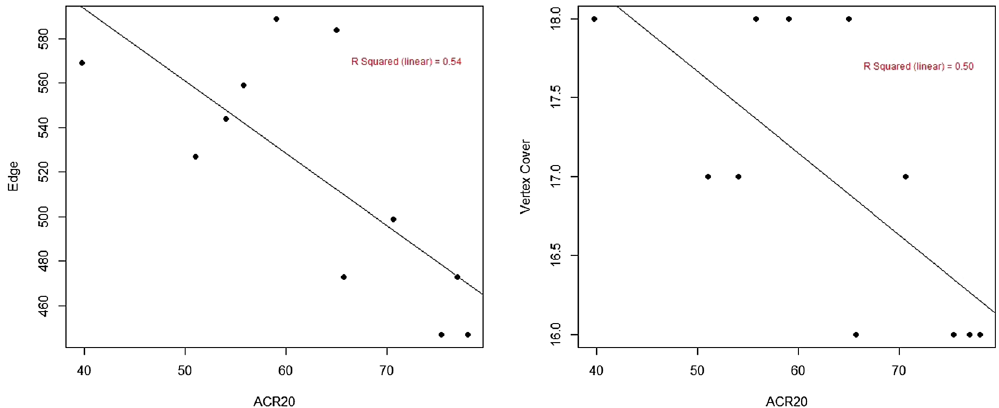
Figure 1. Represents scatter plot of treatment response (American College of Rheumatology 20 response (ACR 20), x-axis) with edges and minimum vertex cover (y-axes). The data points represent different drugs. The results are obtained with deletion of rituximab from the data set. The linear regression coefficient for edges is 0.676 and that for the minimum vertex cover is 0.635.